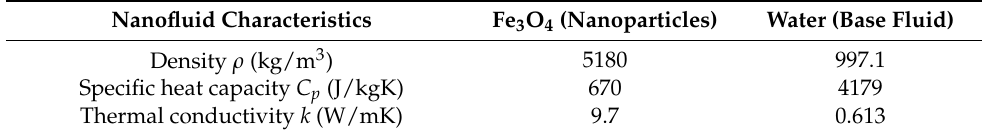
Figure 1. Investigated solar collector. Table 1. Nanofluid thermophysical